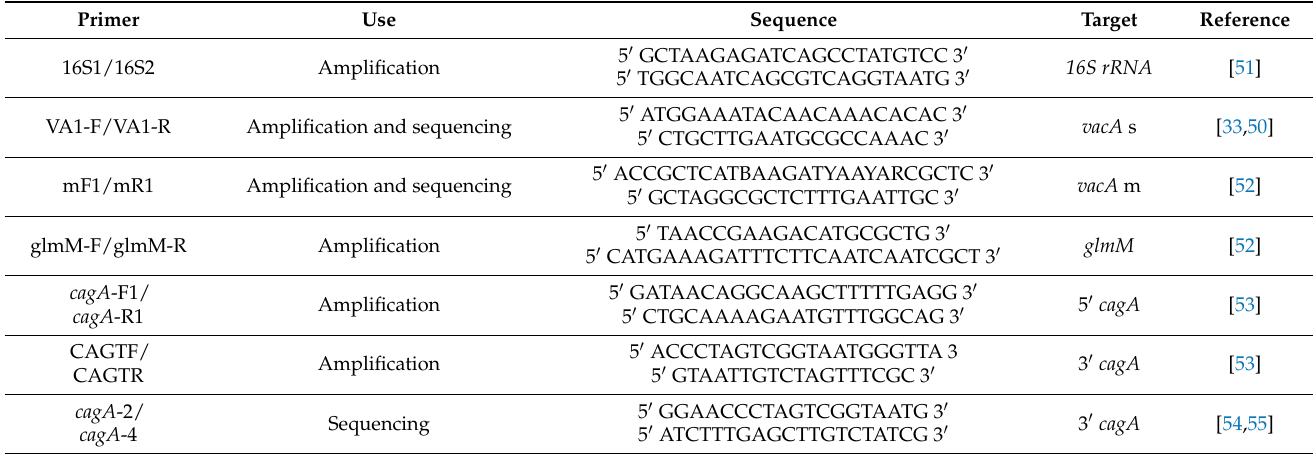
Table 1. Primers used for amplification and sequencing of 16S rRNA, cagA , and vacA